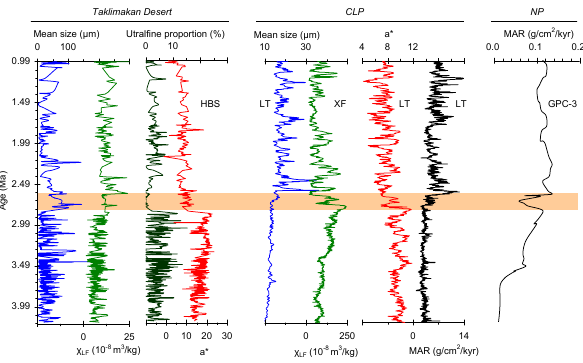
Fig. 5. Time series of the multi-proxy indices from the HBS Section Fig.5 and their correlation with those from the CLP (Sun D. et al., 2008; Sun Y. et al., 2010; Wang F. et al., 2012; Sun and An, 2005) and the NP (Rea et al., 1998). Sea section locations in Fig. 1a. The grey bar indicates the boundary of the most dramatic changes in lithol- ogy and the multi-proxy records. Abbreviations: HBS-Hongbaishan Section, LT-Lingtai Section, XF-Xifeng